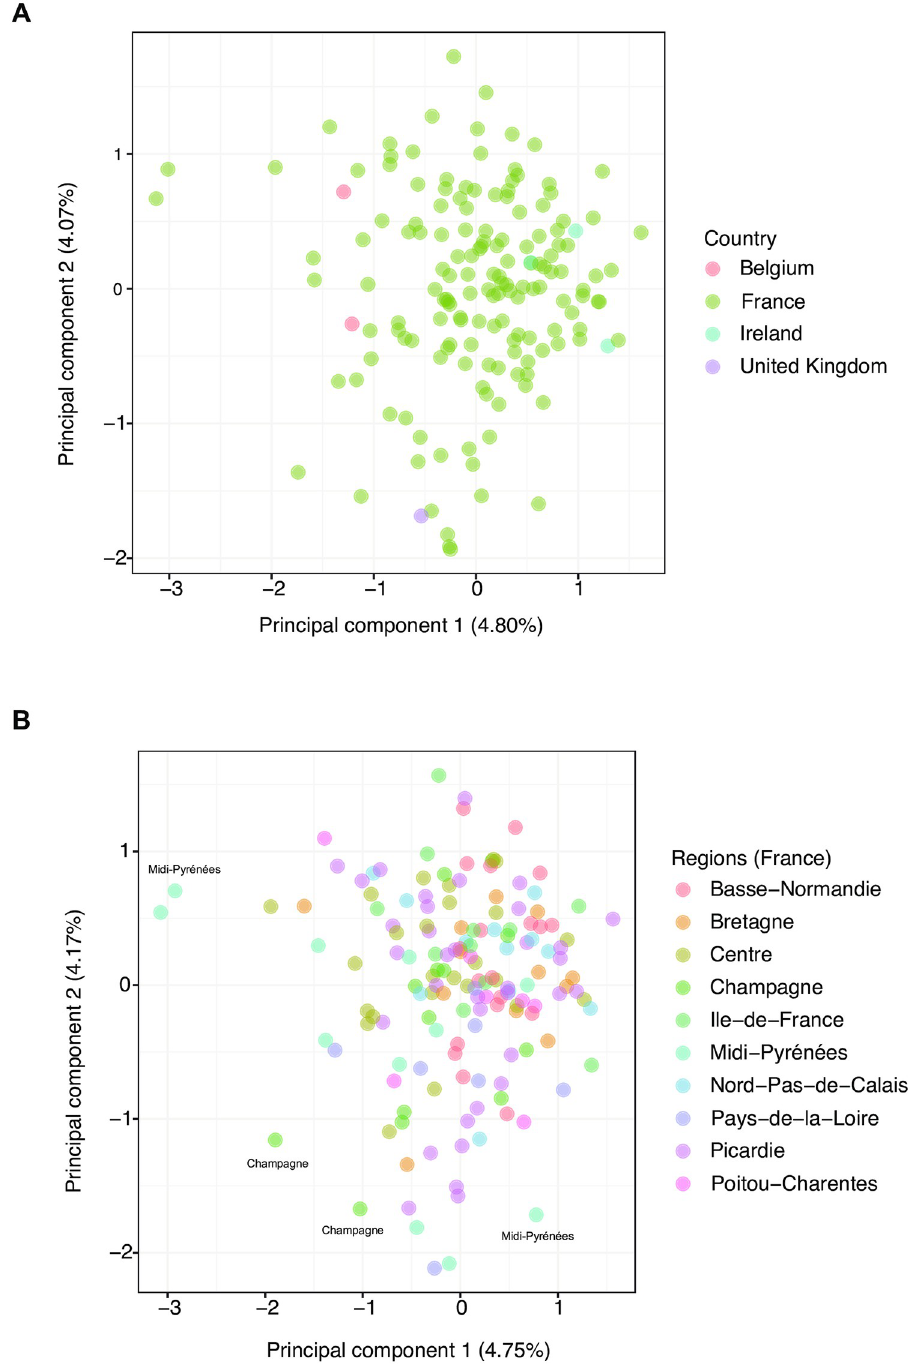
Fig 6. Population structure analyses based on genome-wide markers genotyped on leaf-extracted assemblies of Zymoseptoria tritici strains. A) Principal component analysis of wheat leaf samples collected in France, Belgium, Ireland and the United Kingdom and B) the subset of wheat leaf samples collected in France colored by region.